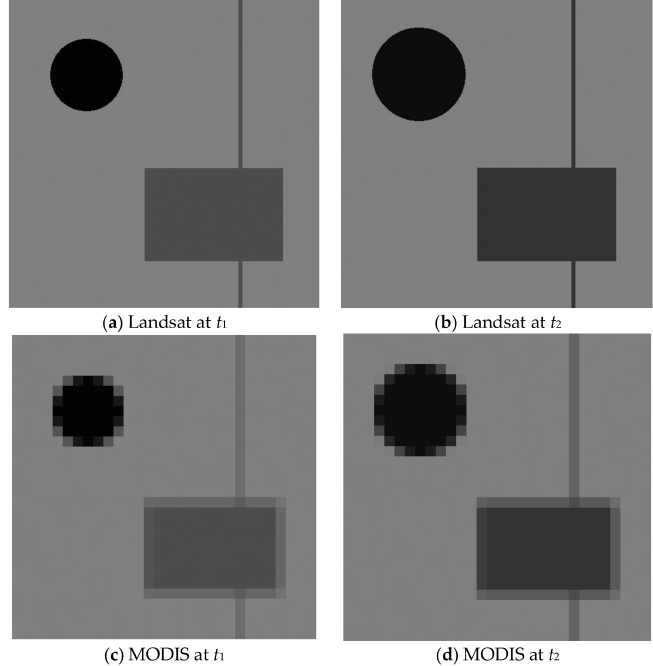
Figure 9. Synthetic data for Landsat and MODIS at two different times. The image size is 480 × 480. ( a , b ) are synthetic Landsat images at two different times; ( c , d ) are synthetic MODIS images at two different